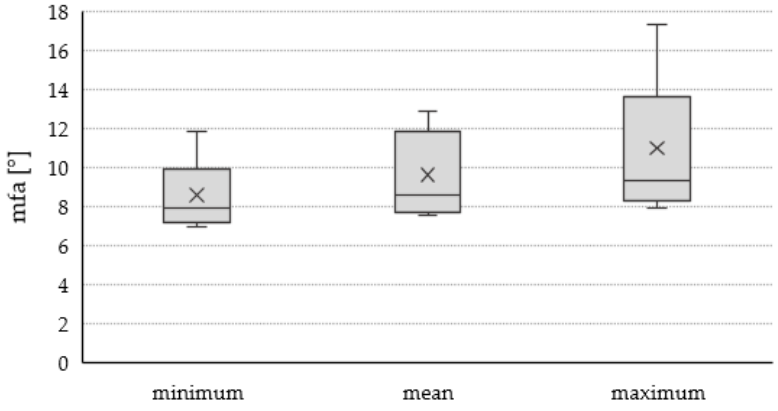
Figure 3. Minimum, mean, and maximum micro fibril angle of n = 18 samples. The mean value is an average of seven measurements within one sample. Minimum and maximum are lowest and highest recorded value of one sample respectively.